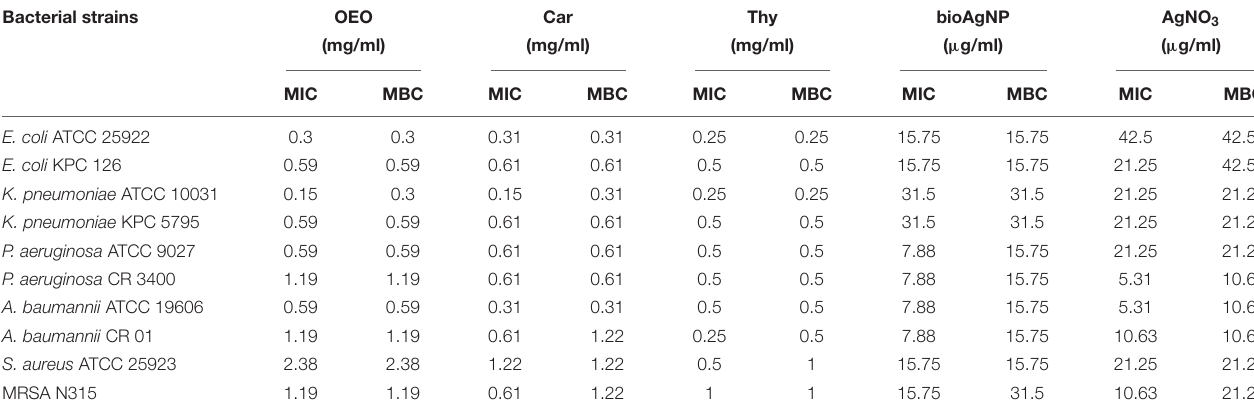
TABLE 1 | Mean of minimal inhibitory and bactericidal concentrations of oregano-derived antimicrobials and silver-based compounds individually. Bacterial strains OEO Car Thy bioAgNP